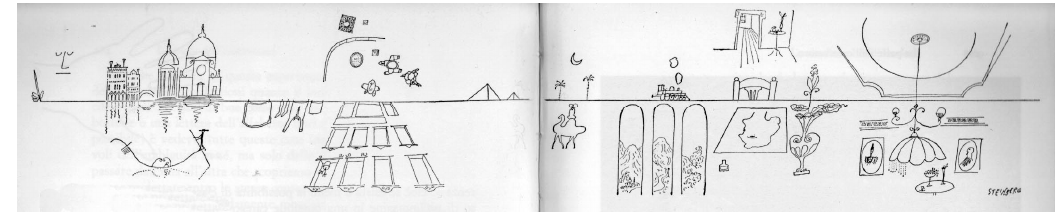
Figure 8. S. Steinberg , Drawing from The New Yorker , 1954.